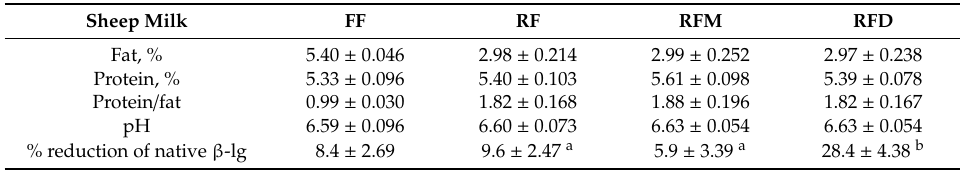
Table 1. Characteristics of sheep cheese milk. Mean of three experiments ± standard deviation. β -lg: β -lactoglobulin; FF: pasteurized (68 ◦ C for 10 min) full-fat milk; RF: pasteurized reduced-fat milk; RFM: pasteurized reduced-fat milk supplemented with microparticulated whey protein (MWP); RFD: reduced-fat milk heated at 72 ◦ C for 10 min.